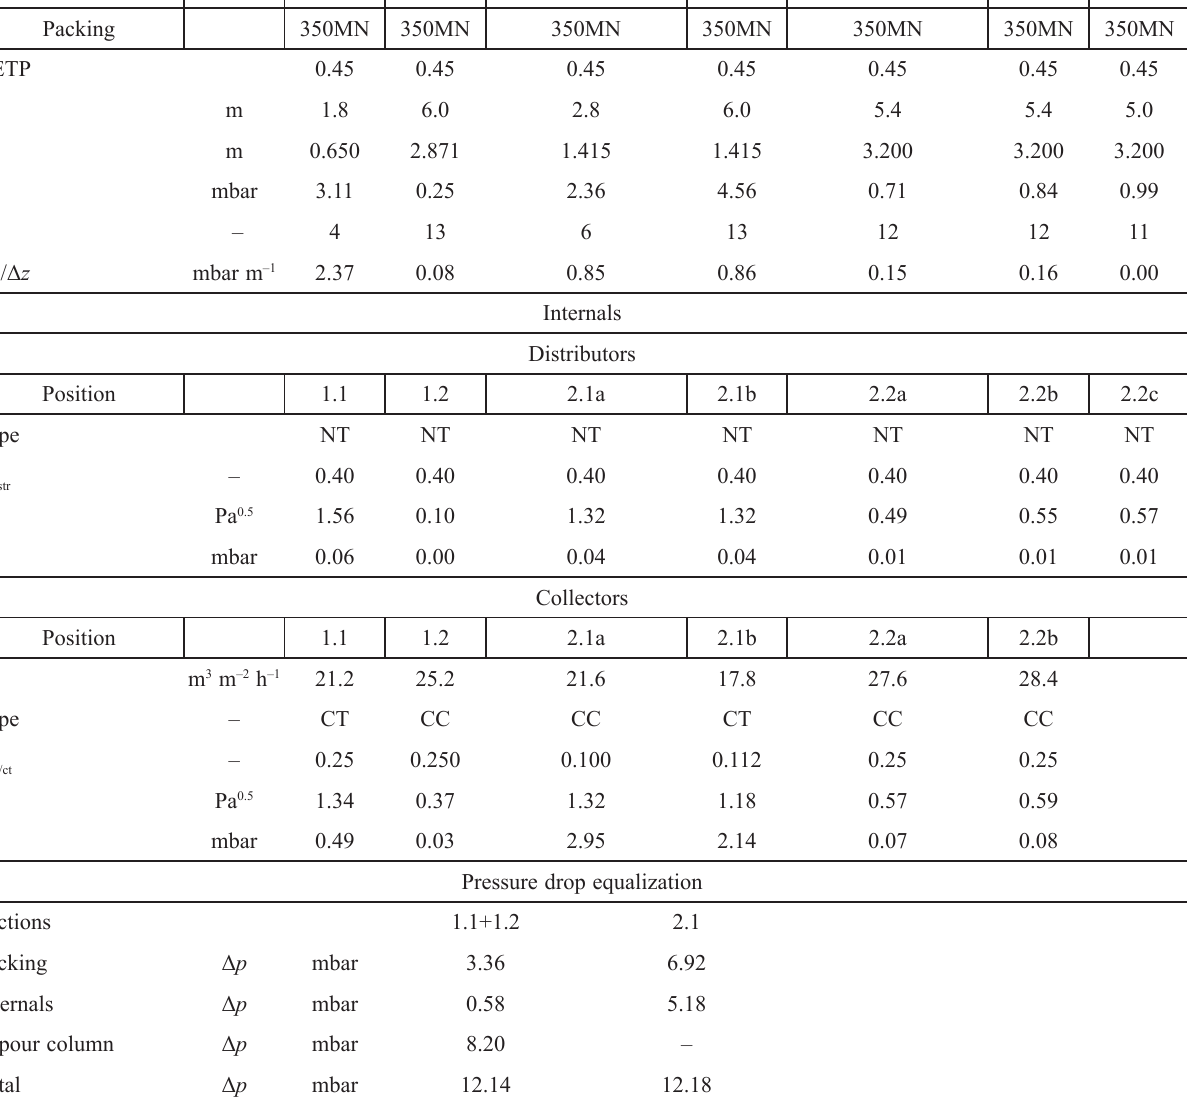
Table 4 – Basic data and estimated pressure drop for packed beds, liquid distributors, and liquid collectors of the packed DWC shown in Fig. 4